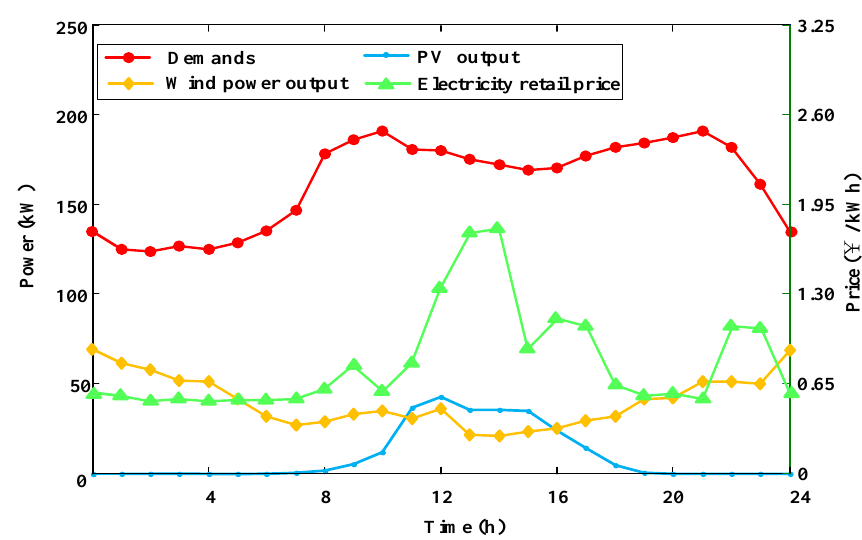
Figure 2. The main structure of the grid-connected microsystem.